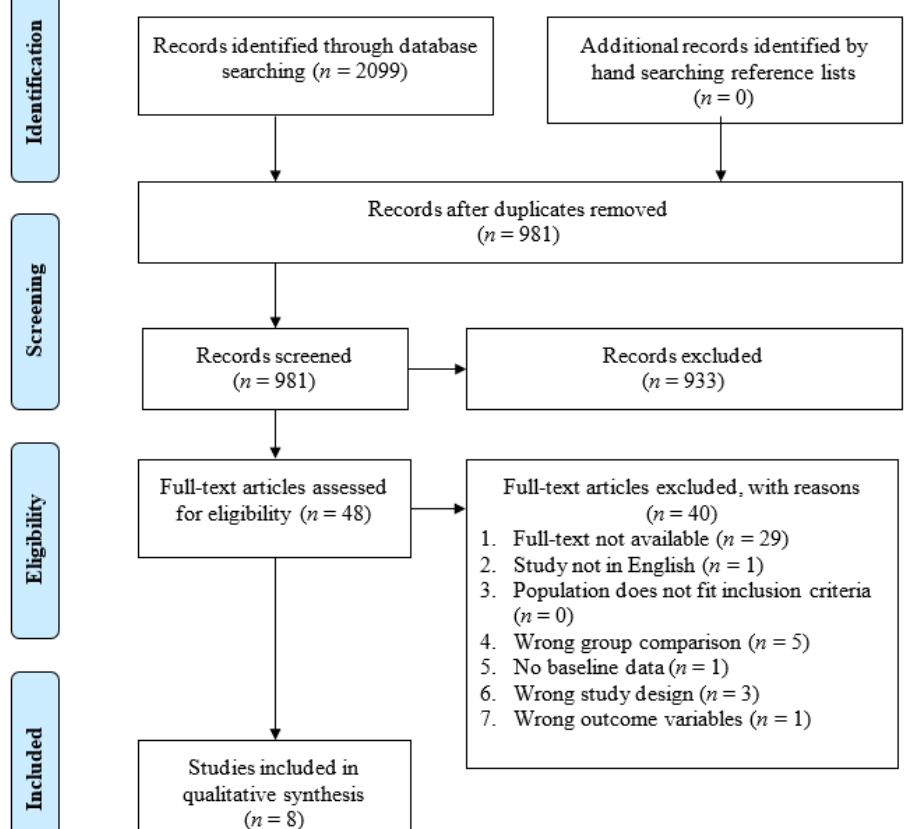
Figure 2. PRISMA flow diagram of the study selection process.